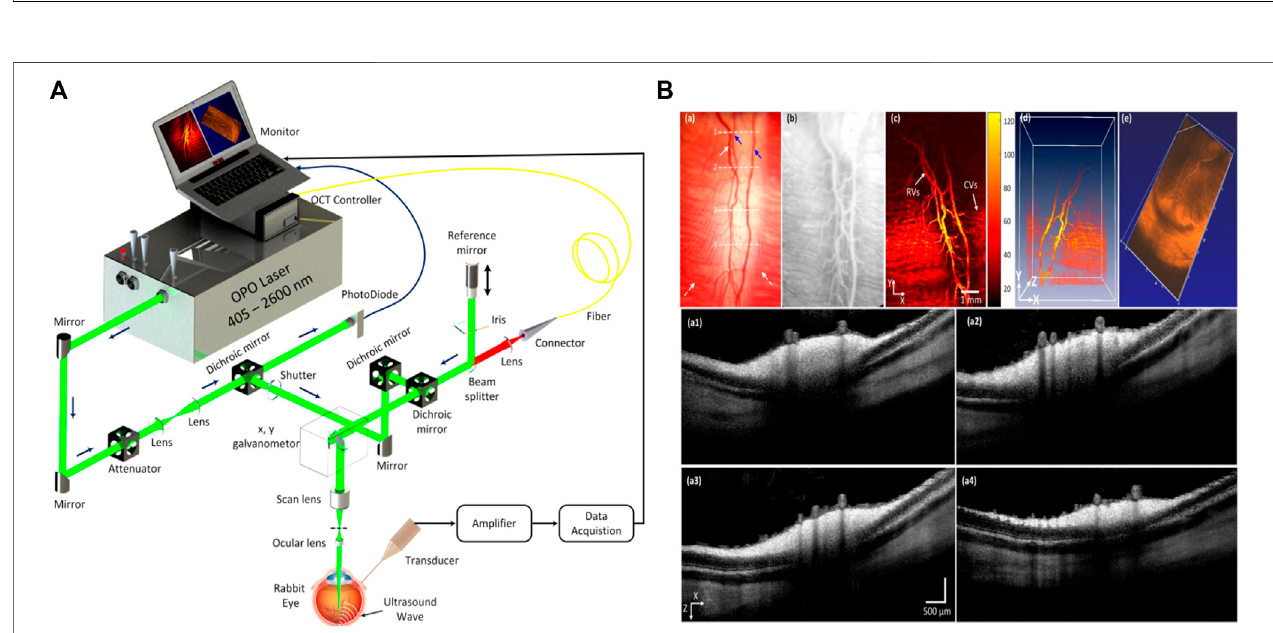
FIGURE 7| Illustration of integrated PAM and SD-OCTto measure retinal metabolic rate ofoxygen. (A) Schematic ofthe experimental setup; (B) circular scanning pattern on the retina; (C) molar extinction coef fi cient spectrum of oxy- and deoxyhemoglobin; (D) a maximum-amplitude-projection PAM fundus image showing major retinal vessels. Bar: 200 mm; (E) an OCT fundus image of the same rat showed in the panel (D) . Bar: 200 mm. Reprinted with permission from [90].